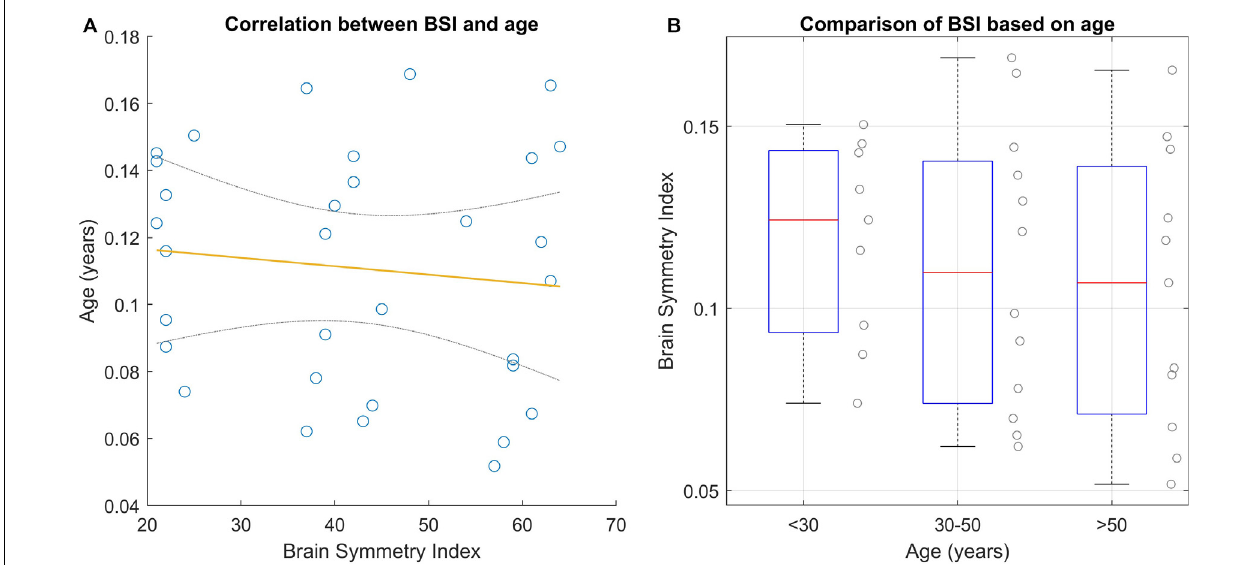
FIGURE 3 | BSI analyses based on age. (A) Shows the correlation between age and BSI using Pearson’s method. The yellow line is the regression line and the gray lines are the CI at 95%. (B) Shows the BSI results based on three clusters.